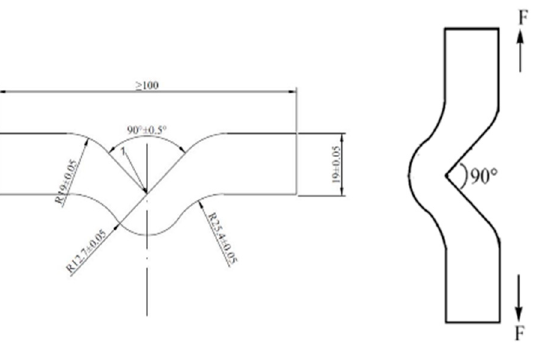
Figure 1. Nicked angle tear test specimen (length 100 mm, width 19 mm, thickness 2 mm, pre-cut angle 90°).